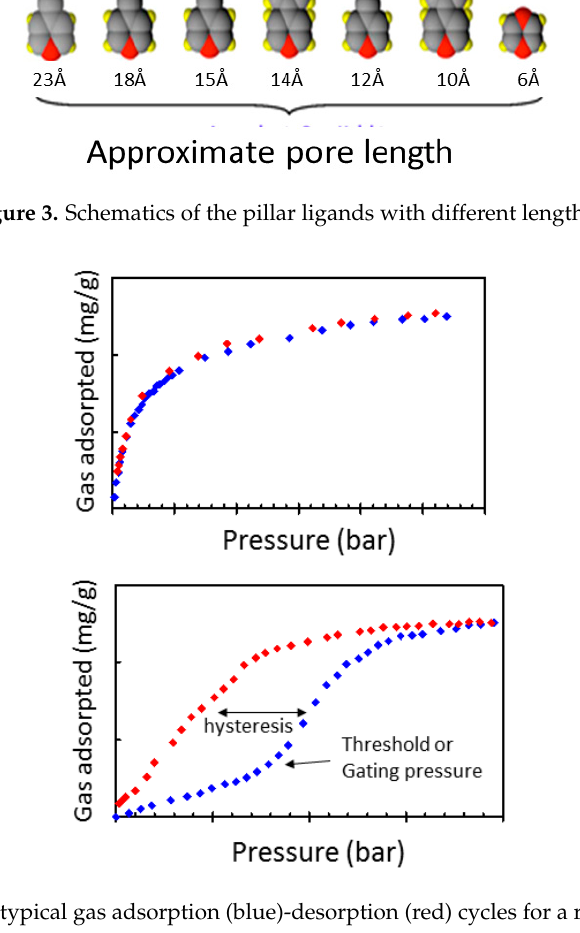
Figure 4. Comparing typical gas adsorption (blue)-desorption (red) cycles for a rigid porous material ( top ) and a flexible MOF ( bottom ). Adsorption in flexible sorbents is associated with a gate-opening effect at a specific threshold condition of temperature and pressure. Desorption is